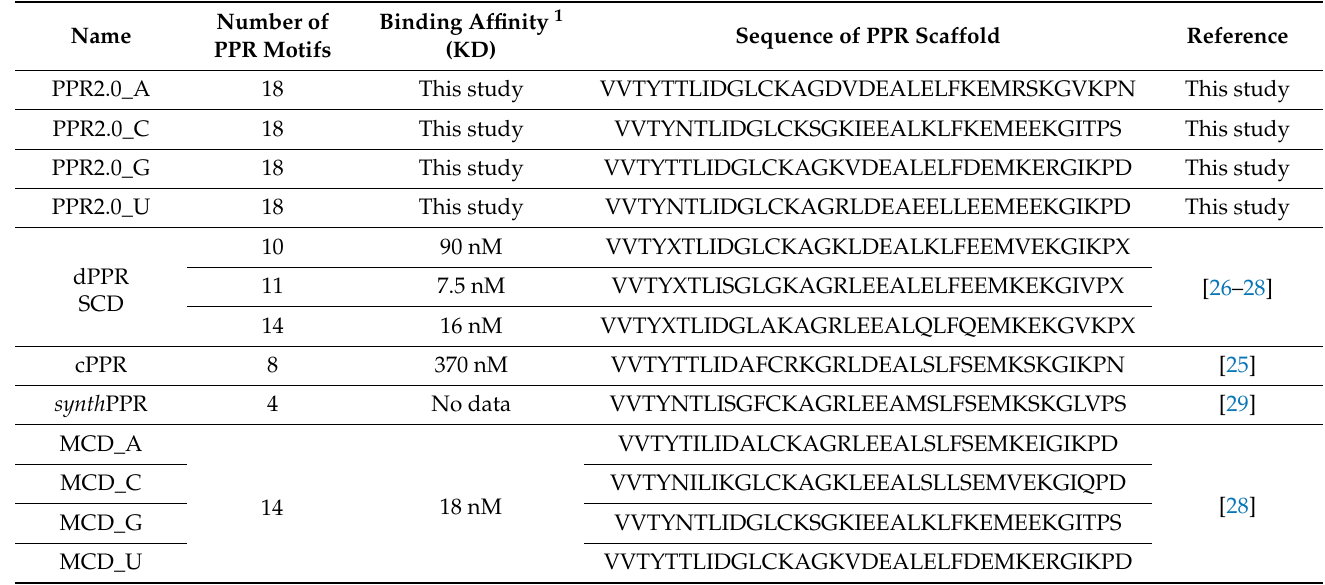
Table 1. Amino acid sequences of PPR scaffolds reported in previous published papers and their binding affinities to target RNA